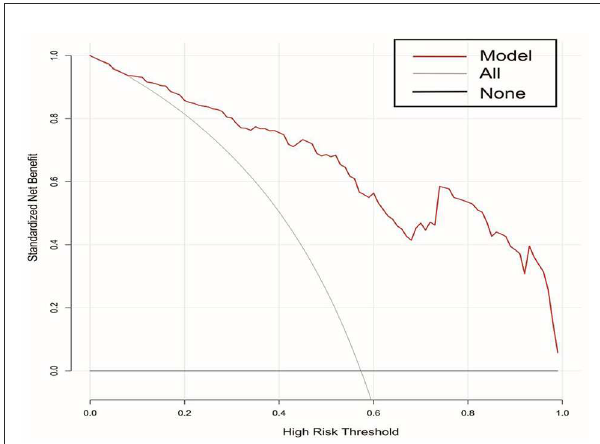
FIGURE4 DCA curves of the nomogram for predicting the risk of poor prognosis in patients with poor-grade aneurysmal subarachnoid hemorrhage following microsurgical clipping. DCA, decision curve